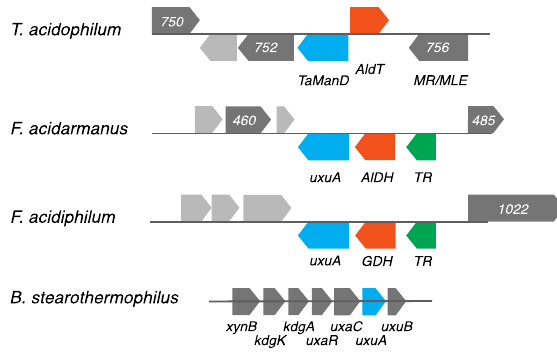
Figure 3. Schematic maps of uxuA mannonate dehydratases and their genomic neighbourhoods in T. acidophilum , F. acidarmanus , F. acidiphilum and B. stearothermophilus . Genes are annotated in the